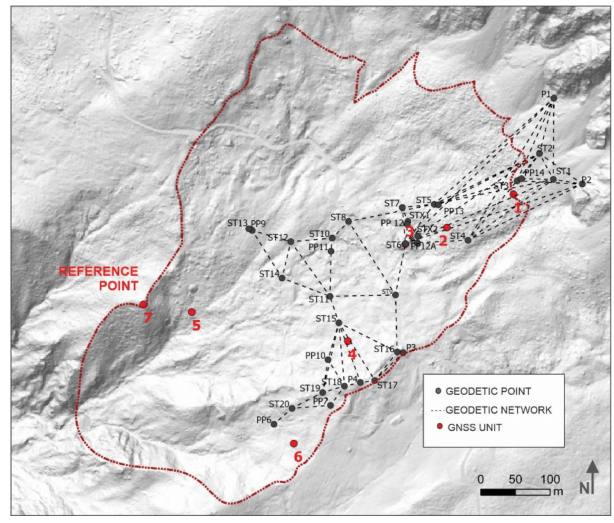
Figure 6. Geodetic network of the landslide